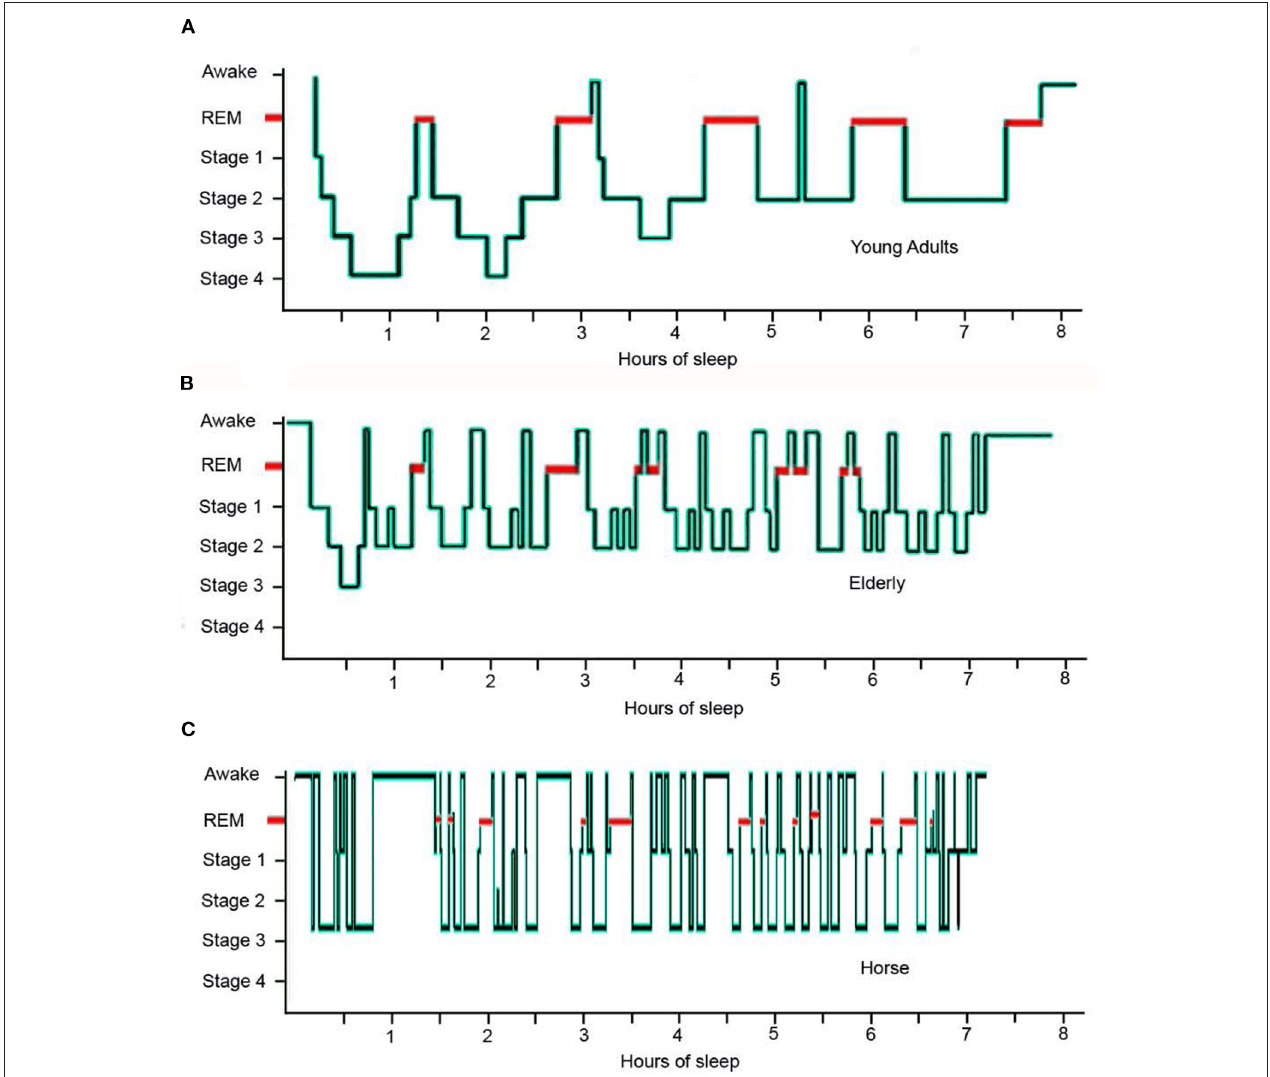
FIGURE 2 | Hypnogram comparing sleep architecture of a typical young human adult, an elderly human adult and an adult horse over an eight hour sleep episode: (A) the young adult experiences 5REM sequences and 2 short sequences of wakefulness; (B) the elderly individual experiences 8 disturbed REM sequences and multiple sequences of wakefulness accompanied by a distinct lack of stage 4 sleep; (C) the horse experiences 13 disturbed REM sequences and multiple sequences of wakefulness accompanied by a distinct lack of stage 4 sleep [adapted from (42,